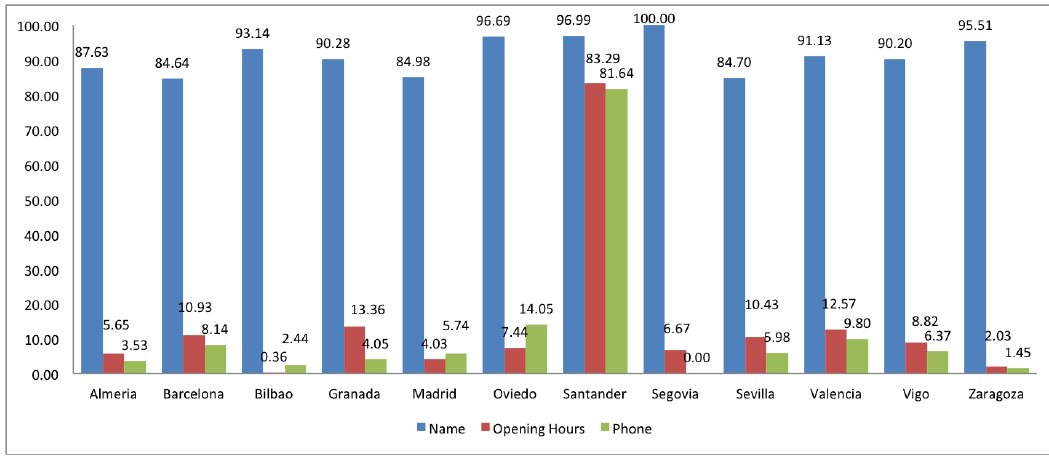
Figure 5. Completeness study in Spain. Percentage of name, opening hours and phone in